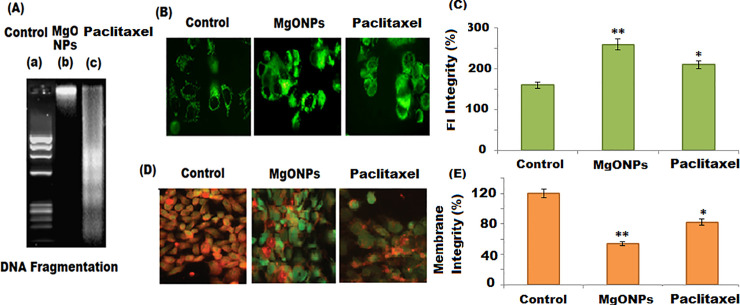
(A) Light microscope showing DNA fragmentation in MCF-7 cells, (B) Fluorescence microscopic images of MCF-7 cells treated with CM-H2 DCFDA, intracellular ROS indicator after treatment with MgONPs (C) quantification of ROS level using fluorescence spectroscopy, (D) Fluorescence microscopic images of MCF-7cells treated with JC-1 staining to assess the mitochondrial membrane potential (ΔΨm) after treatment with the MgONPs for 24 h in comparison with Piacitaxel (40×) (E) Bar diagram illustrating the percentage of cells with disrupted MMP.